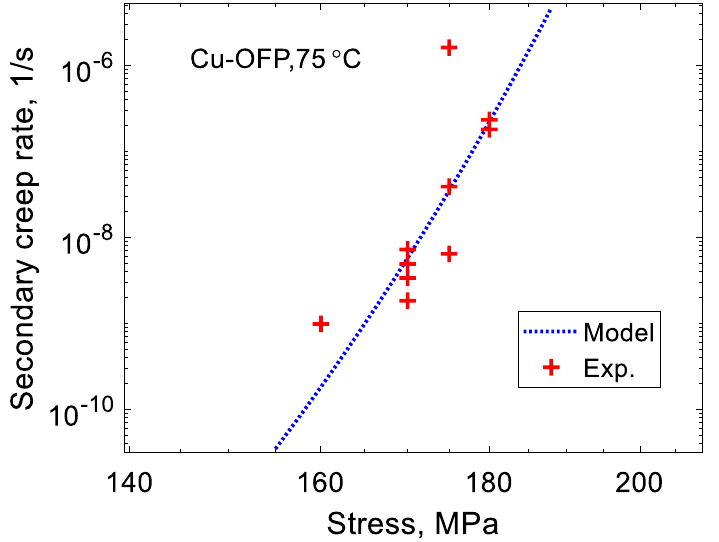
Figure 3. Predicted secondary creep rate with the dislocation mobility in Equation (9).